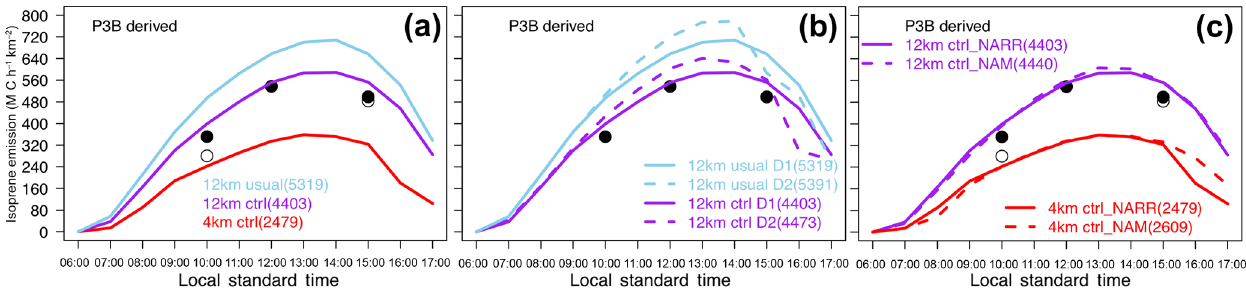
Figure 7. Comparing NUWRF–MEGAN daytime isoprene emissions in Conroe on 11 September 2013 with the observation-derived emis- sions. The filled and open black circles indicate the calculations based on PBLHs from the 12 and 4km NARR IC–LBC control runs, respectively: (a) evaluating the impact of NUWRF land initialization and grid resolution; (b) evaluating the impact of NUWRF simulation length, including 1-day and 2-day forecasts, on the 12km grid; (c) evaluating the impact of NUWRF atmospheric initialization (using NARR and NAM) on 12 and 4km grids. The daytime-integrated emissions (MCkm − 2 ) are included in the parentheses. Control is denoted by ctrl.